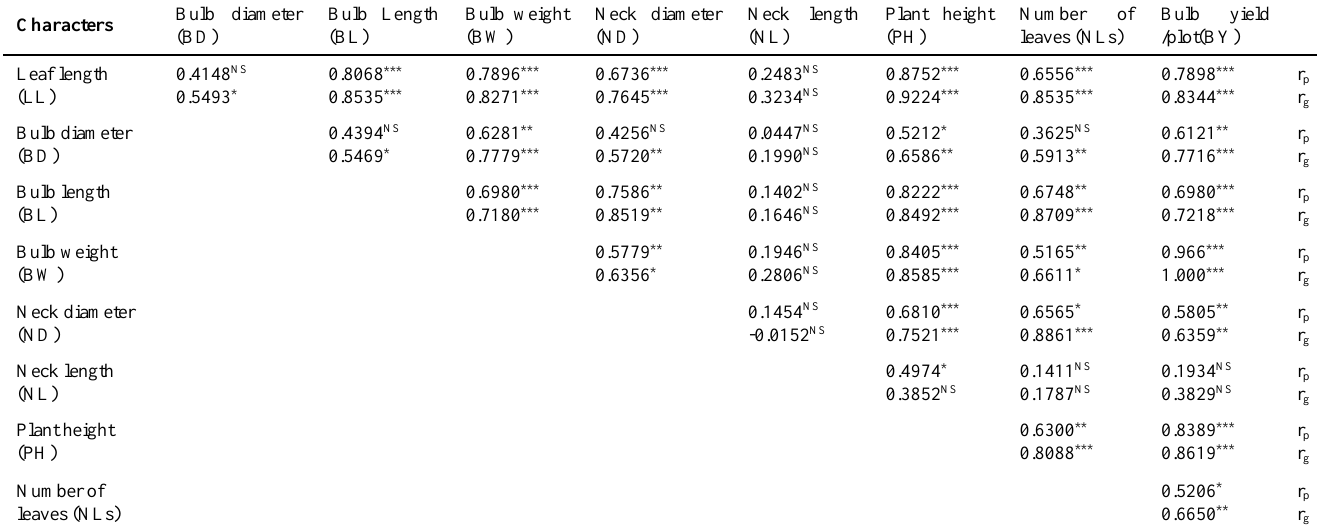
Table 3 . Values of phenotypic (upper values) and genotypic (lower values) correlation coefficients for nine quantitative characters in onion